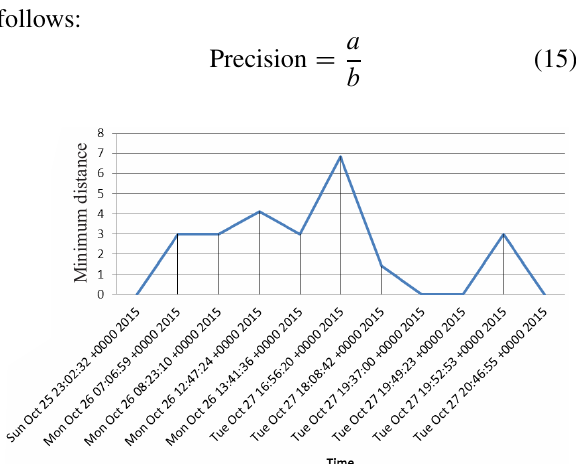
Fig. 8 Trend of reply number changes for the hottest event over time.